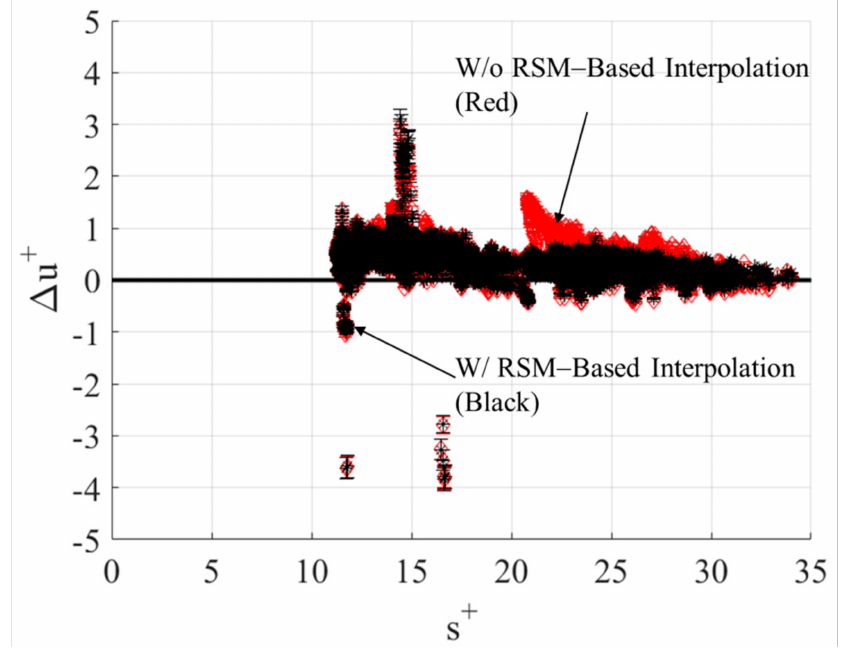
Figure 11. Resulting ∆ u + obtained from methods with and without RSM-based interpolation. Figure 12 enlarges the ∆ u + based on the datasets with RSM-based interpolation,